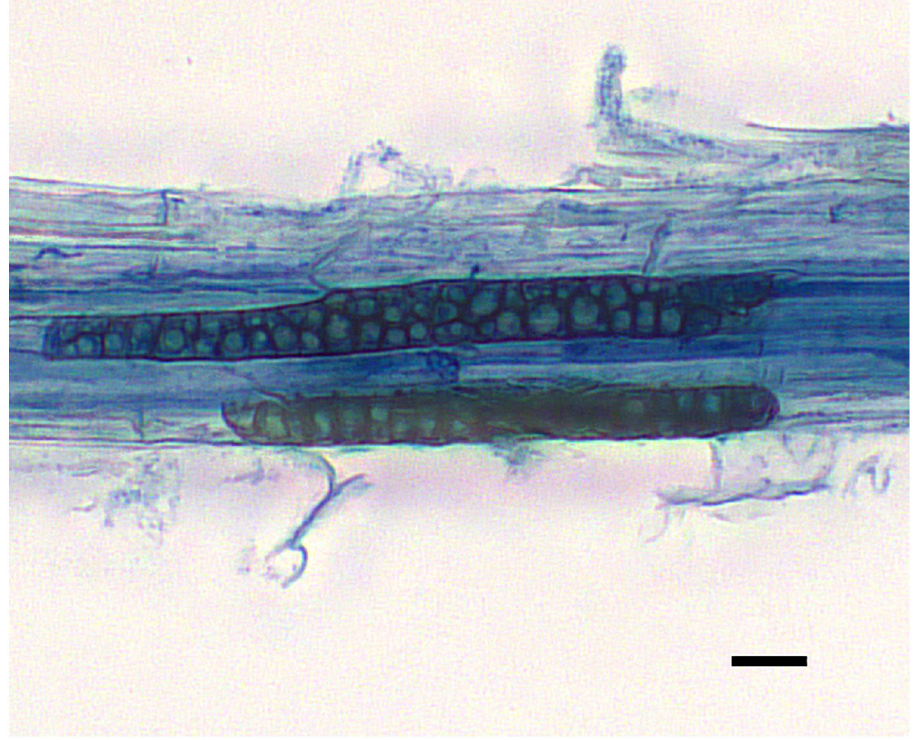
Fig 1. Chlamydospores of M . bolleyi in root of B . distachyon . Scale bar = 10 µ m.